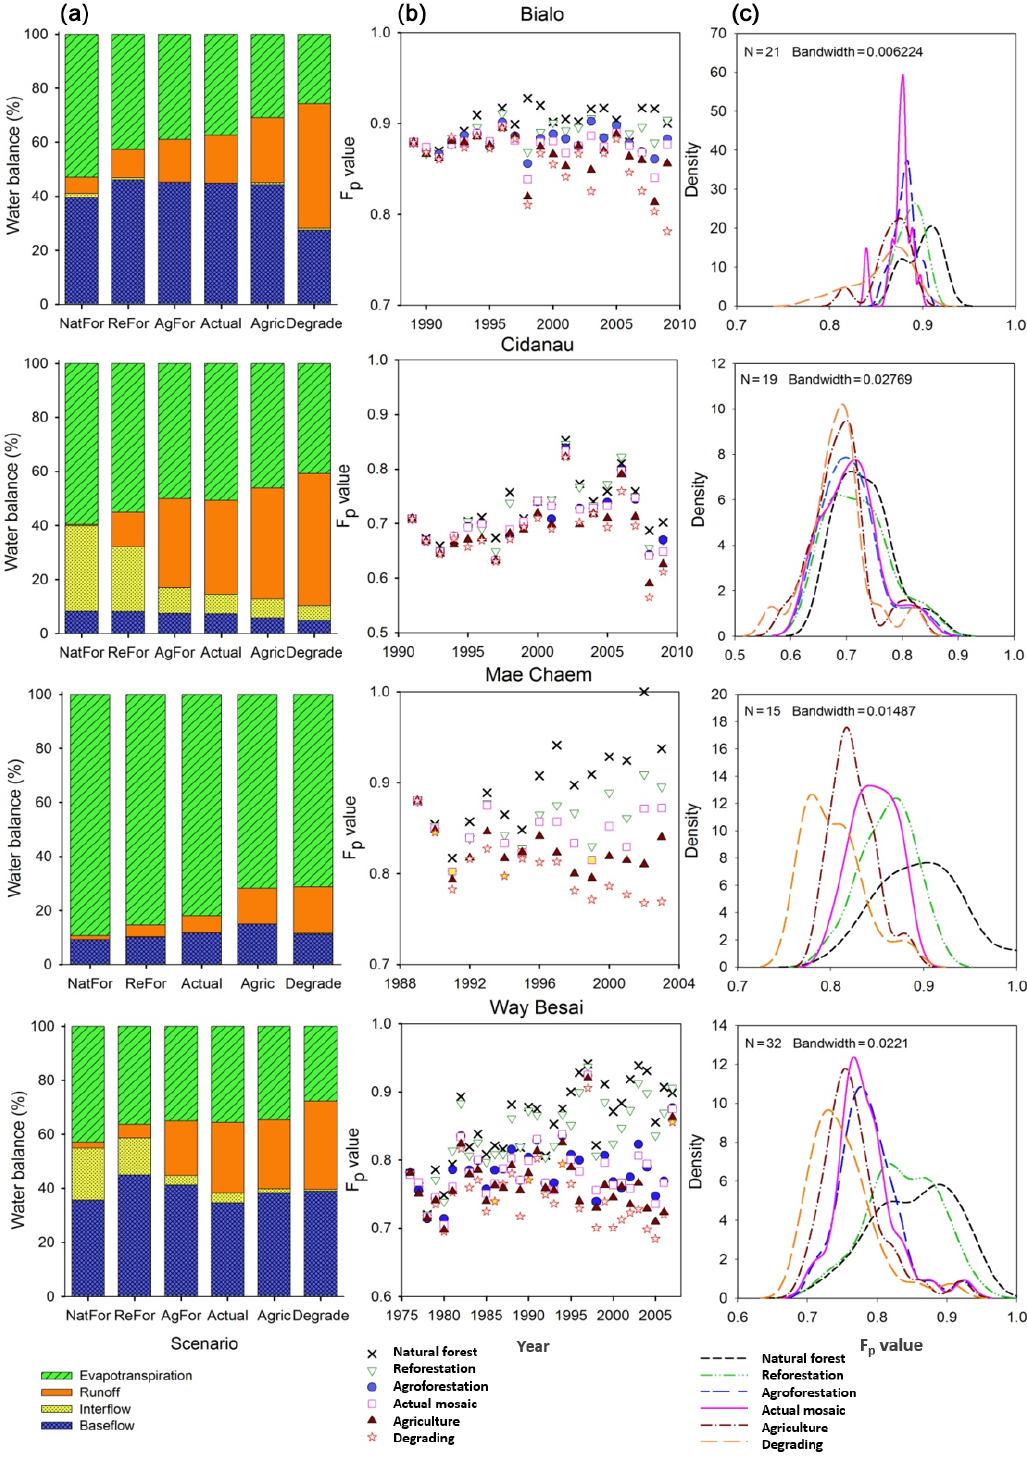
Figure 5. Effects of land cover change scenarios (Table 4) on the flow persistence value in four watersheds, modelled in GenRiver over a 20-year time period, based on actual rainfall records; (a) the average water balance for each land cover scenario, (b) the F p values per year and land use, (c) the derived frequency distributions (best-fitting Weibull